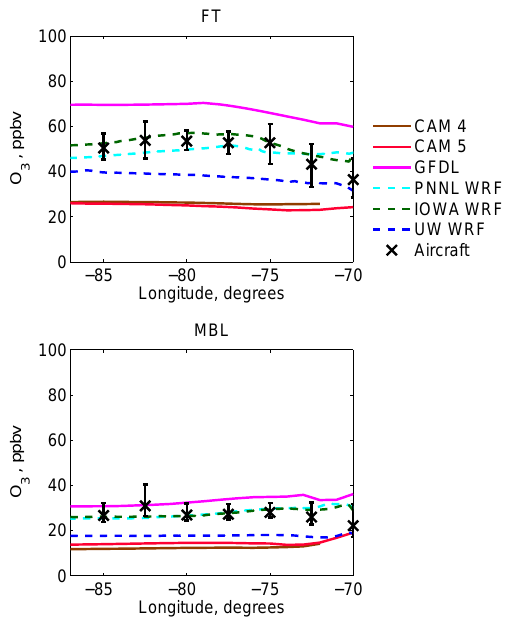
Figure 15. Total modeled black carbon aerosol mass concentration (µgm − 3 ) along 20 ◦ S compared with C-130 single-particle soot photometer measurements (diameters of 0.087–0.4µm).